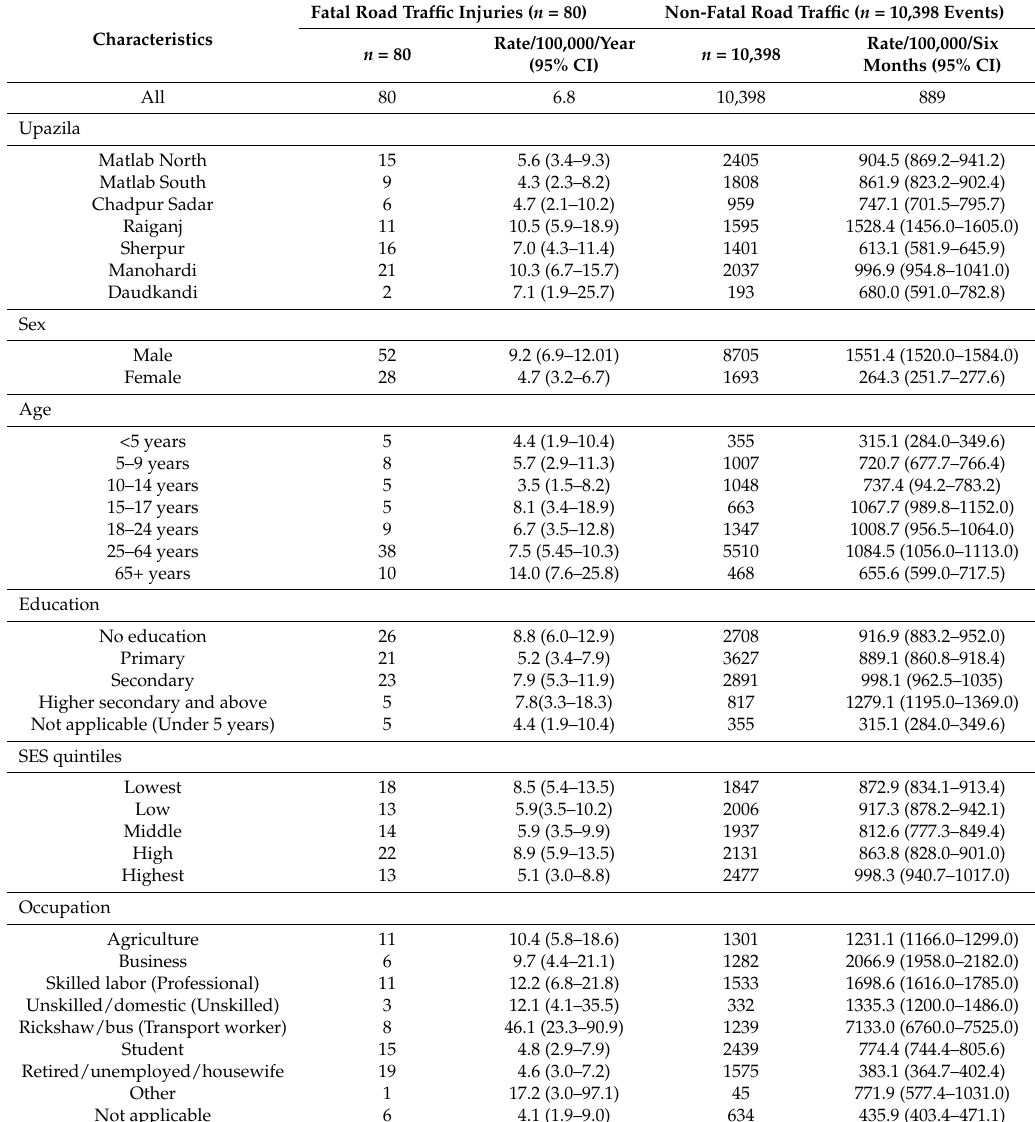
Table 2. Fatal and non-fatal RTI rates (per 100,000) by sub-districts, sex, age, level of education, SES index, and